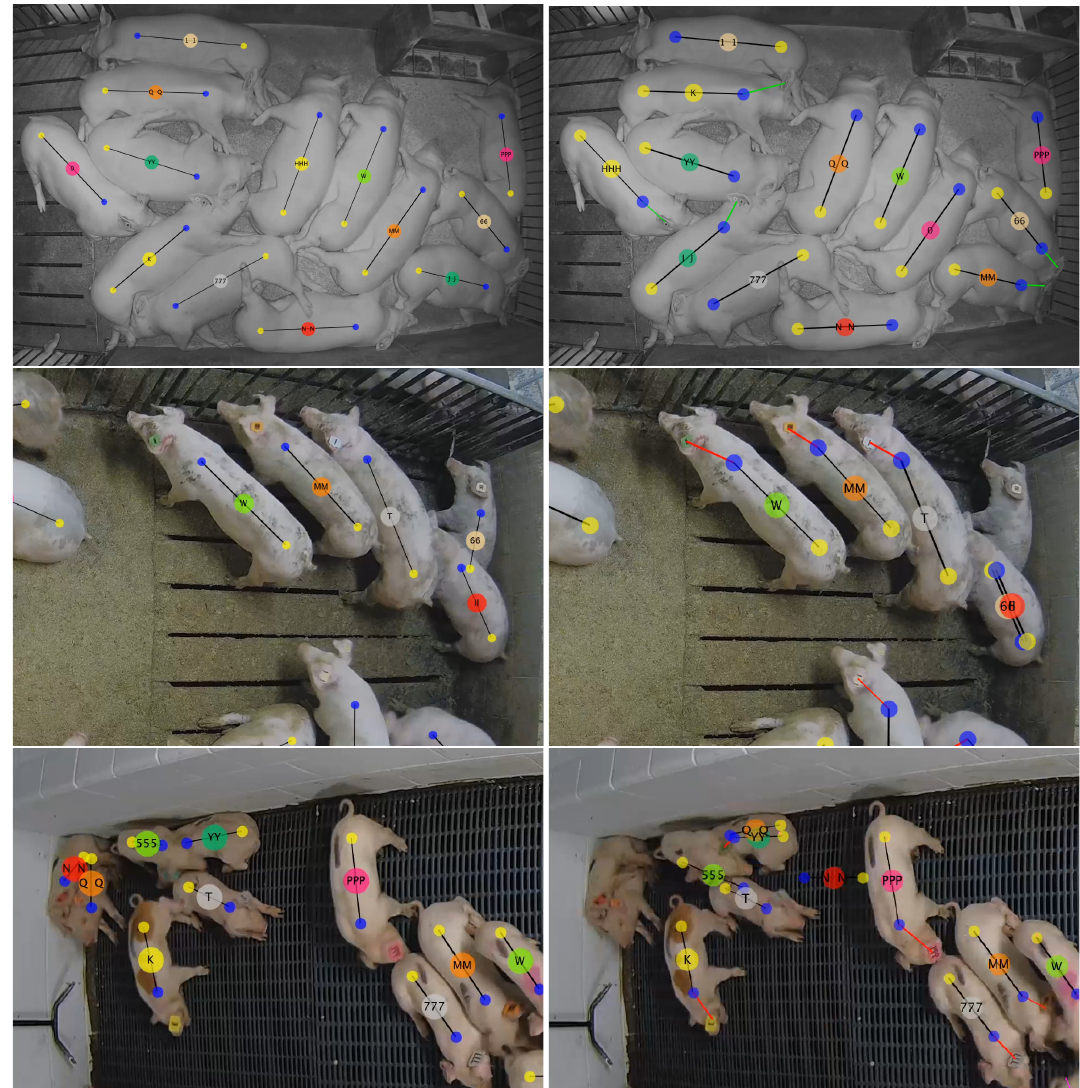
Figure 10. Failure cases for the proposed method in three different scenarios. The left images contain ground truth annotations and the right images are visualizations of the output of the proposed